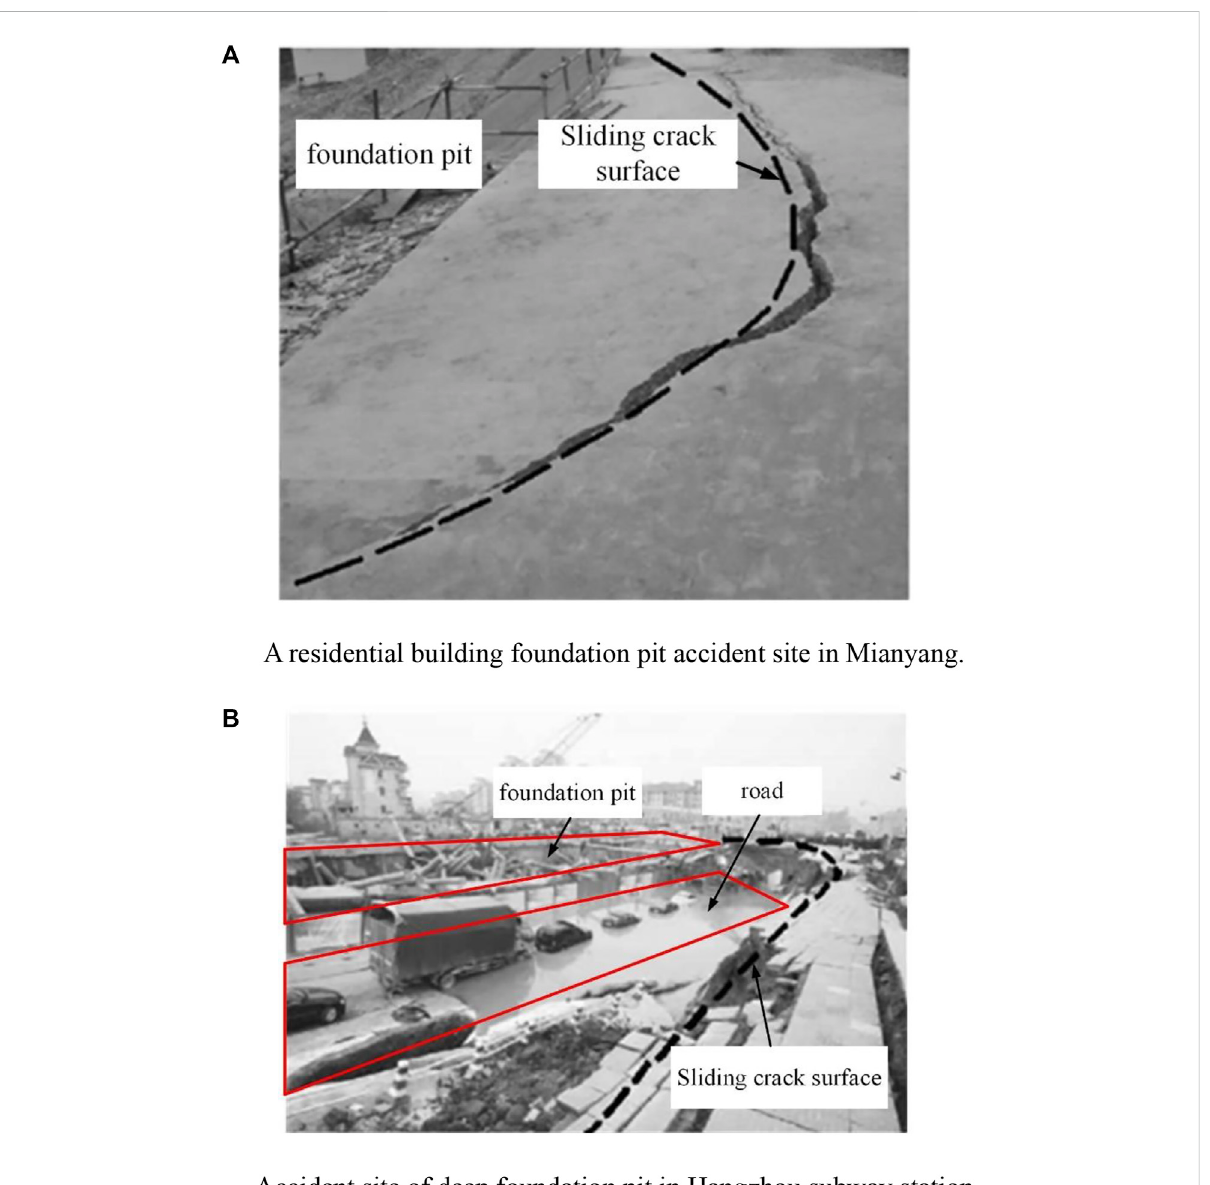
FIGURE 1 Typicalexampleofthein fl uenceofafoundationpitonitsinteractionwiththesurroundingenvironment(Lietal.,2014). (A) Aresidentialbuilding foundation pit accident site in Mianyang. (B) Accident site of deep foundation pit in Hangzhou subway